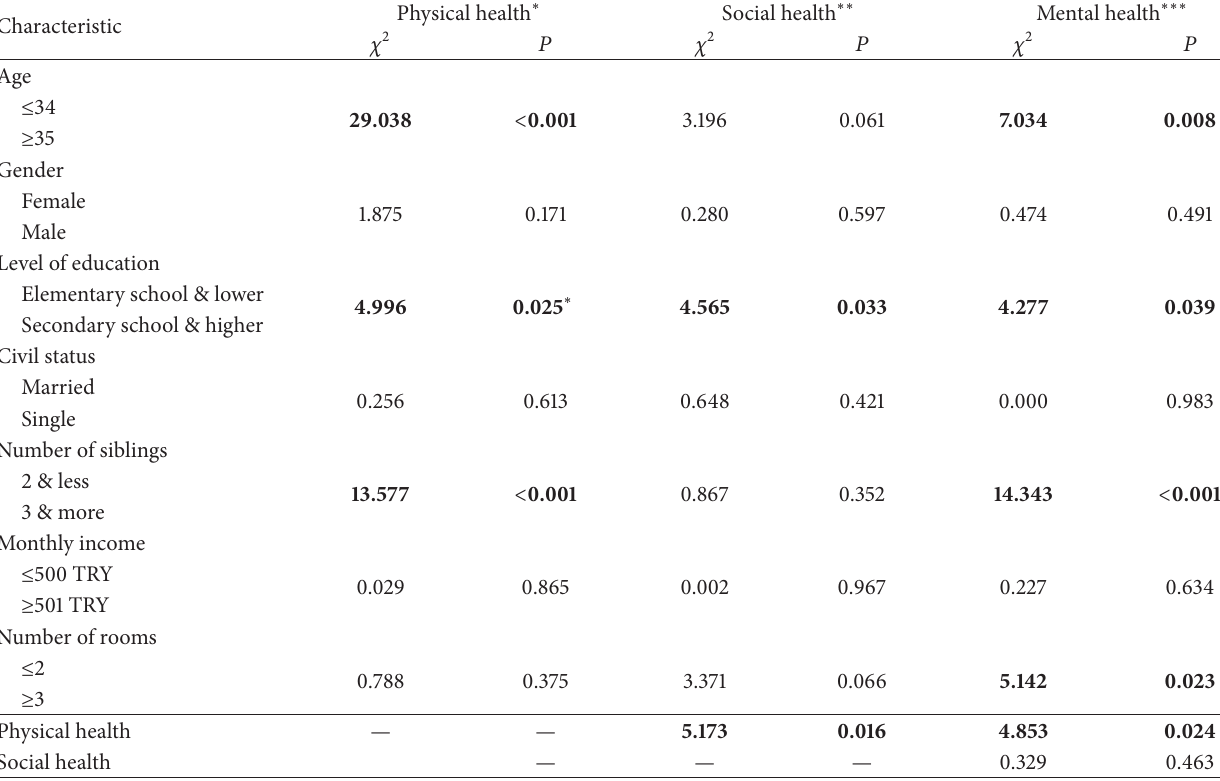
Table 2: Relationship between health statuses and demographic characteristics of the